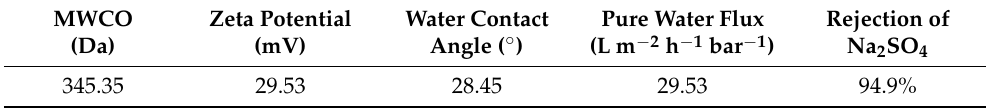
Table 1. Main parameters of HA-TFC i